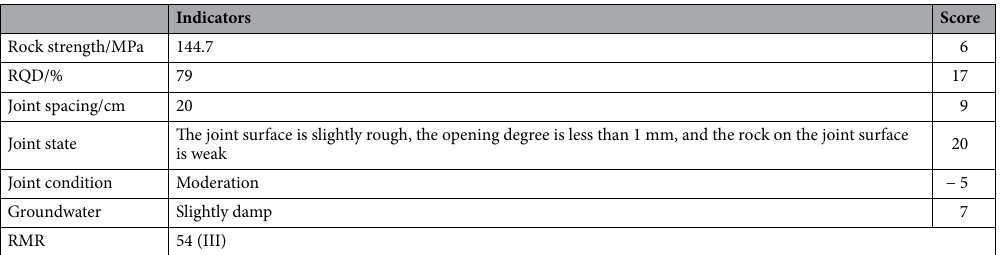
Table 7. RMR classification value of slope rock